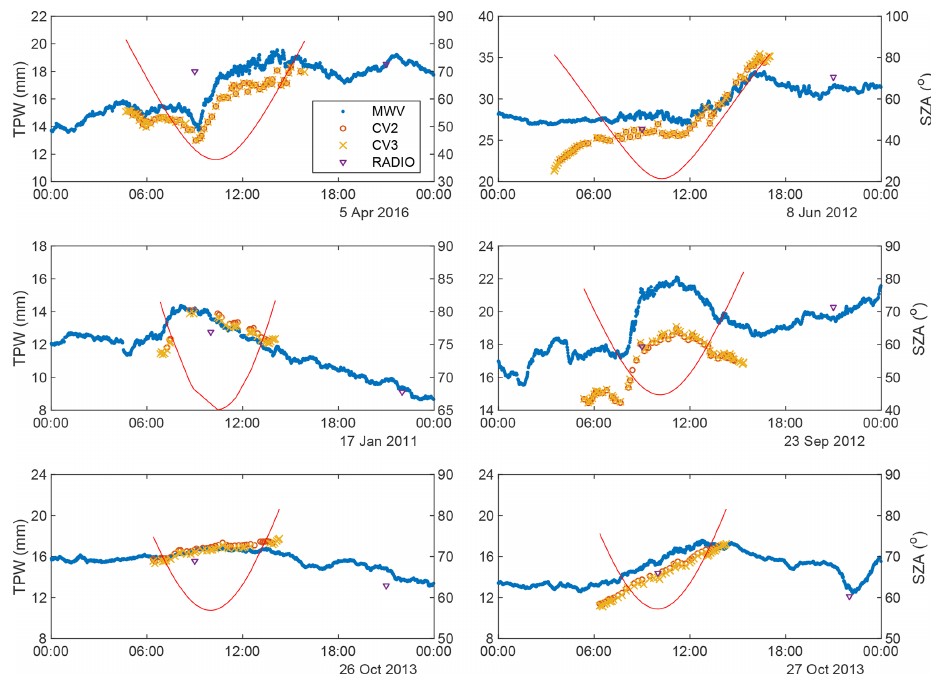
Figure 5. Diurnal variation in total precipitable water from the radiosonde (magenta triangle), microwave radiometer (blue dots) and Cimel sun photometer (V2 and V3 of the algorithm, red circle and orange cross, respectively) for 6 selected days (i.e. to cover all seasons and have a relative high number of Cimel sun photometer measurements). The time is in UTC (i.e. local time – 2h). The red line indicates the range of the SZAs under which Cimel sun photometer measurements were performed.